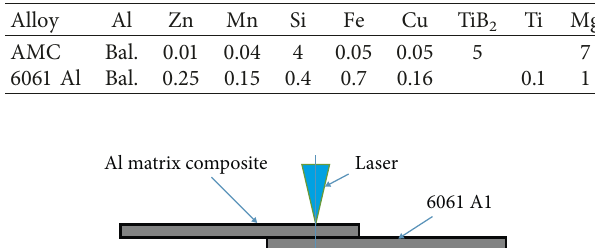
Table 1: The chemical composition of two alloys (wt.%).